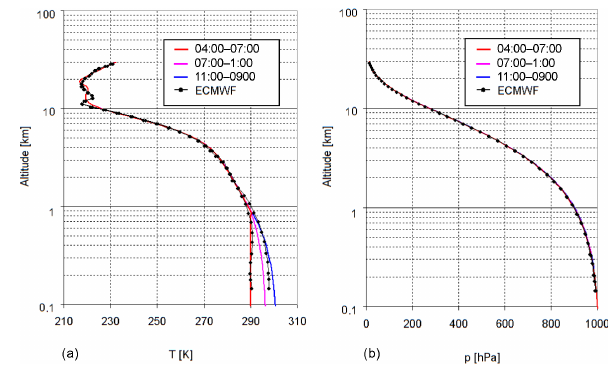
Figure 4. Extracted temperature (a) and pressure (b) profiles for the three periods on 8 July 2013. Also shown are ECMWF profiles above Mainz for 06:00 and 18:00. To better account for the diurnal variation of the temperatures near the surface, below 1km the tem- perature is linearly interpolated between the surface measurements and the ECMWF temperatures at 1km (for details see text). Note that the altitude is given relative to the height of the measurement site (150m).